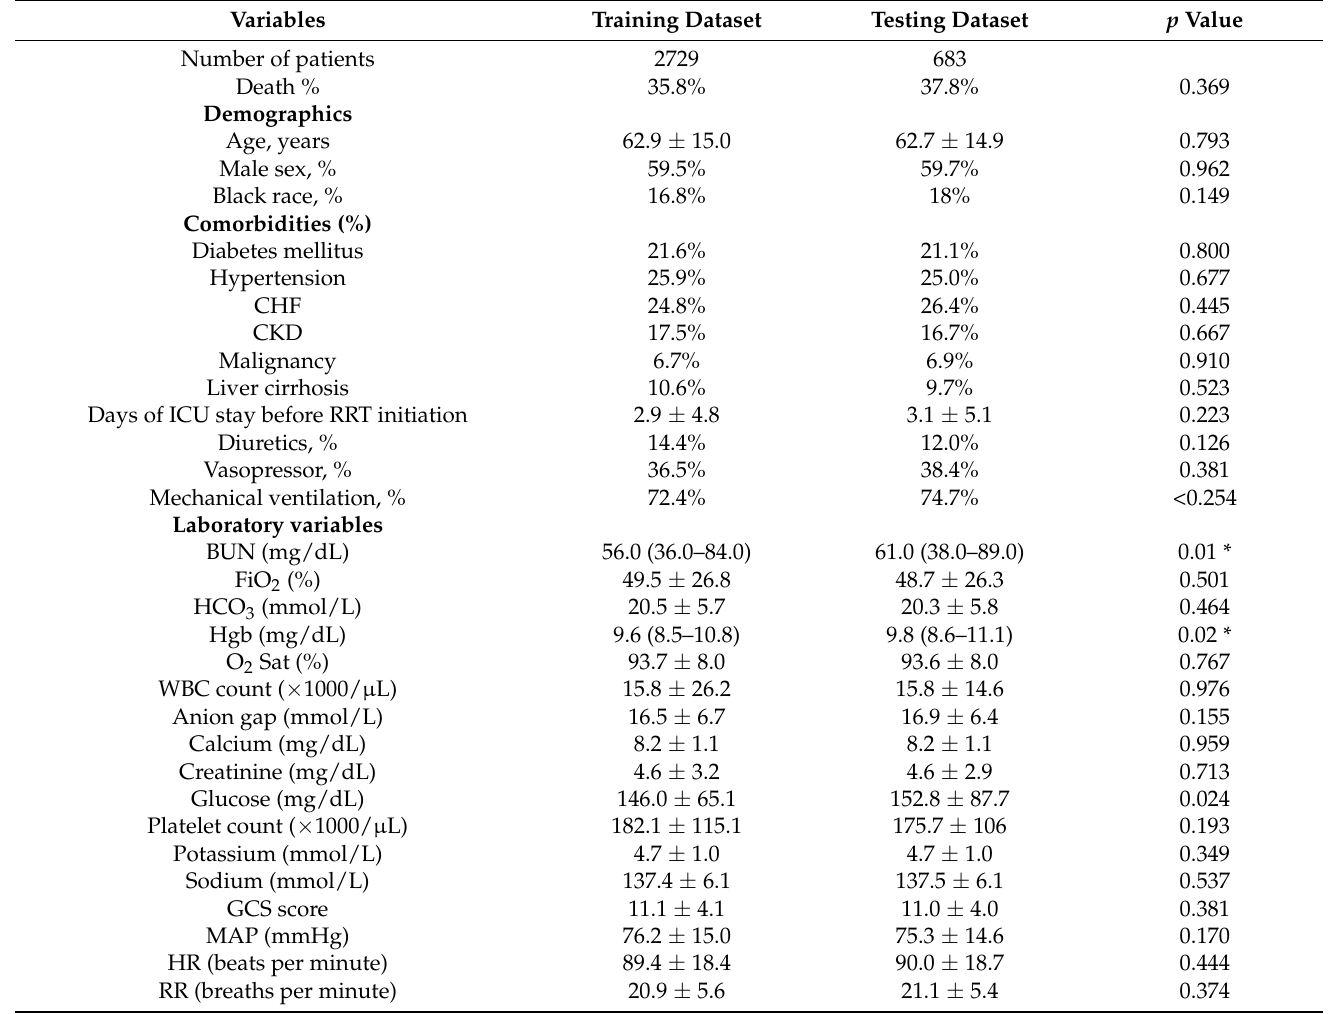
Table 1. Baseline characteristics of the patients requiring renal replacement therapy between the training and testing datasets of pooled